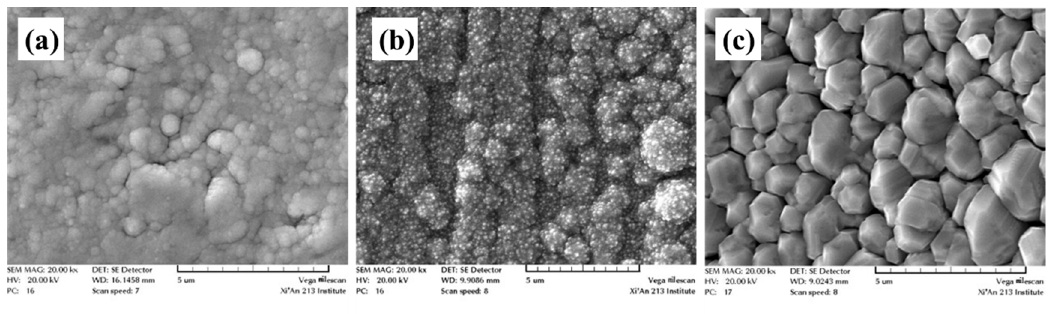
Figure 3. SEM images of Cu foil. ( a ) Sample A, ( b ) Sample B, ( c ) Sample C.